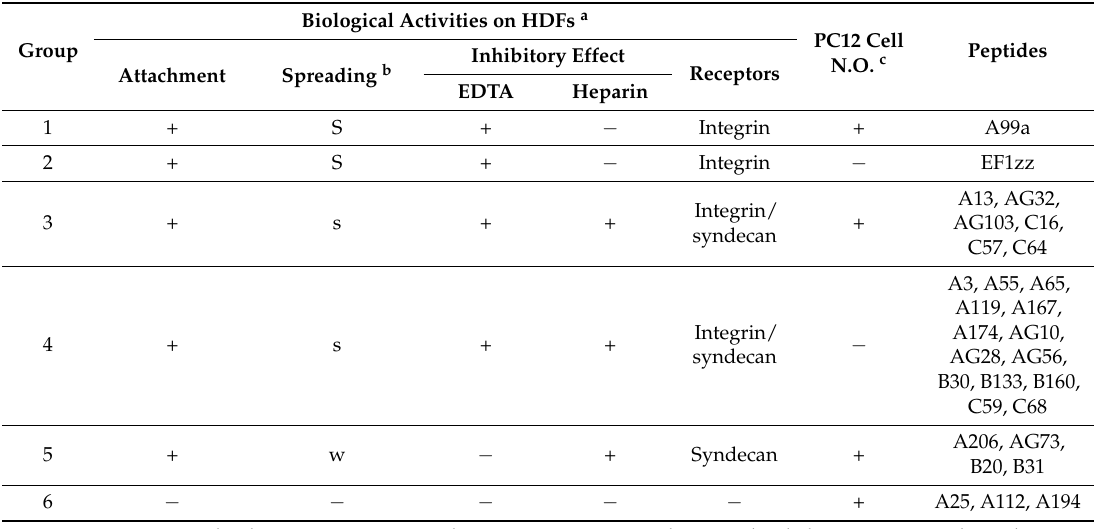
Table 2. Twenty-nine peptide–chitosan matrices could be divided into six categories depending on their biological activities.